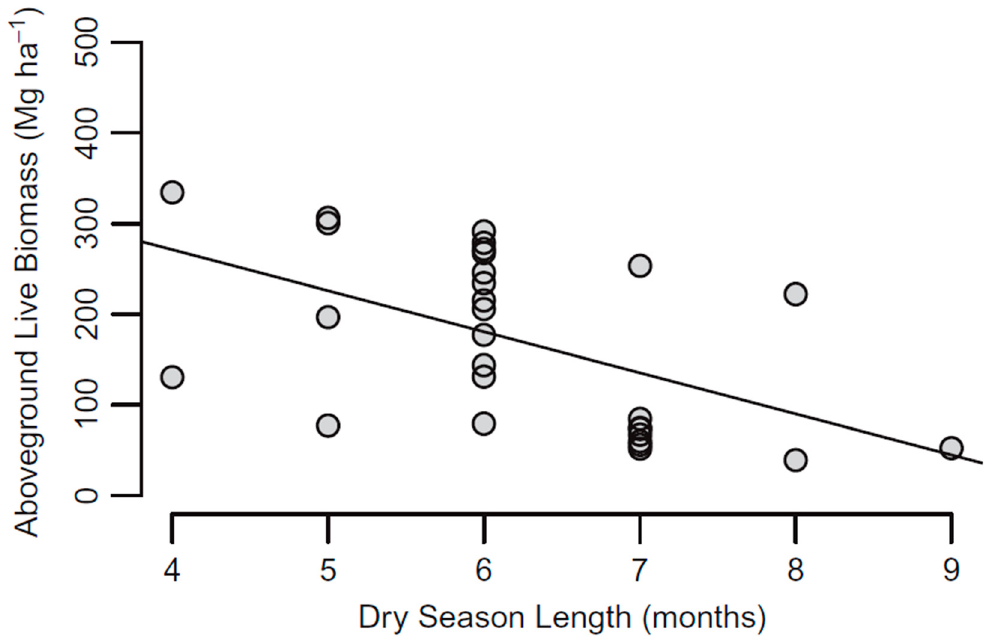
Figure 4. The relationship between the above-ground biomass (AGB) and the length of the dry season with plots from around the globe. The figure is reprinted from Forest Ecology and Management, 276, Becknell et al. Aboveground biomass in mature and secondary seasonally dry tropical forests: A literature review and global synthesis. Forest Ecology and Management 2012. page 91, with permission from Elsevier.